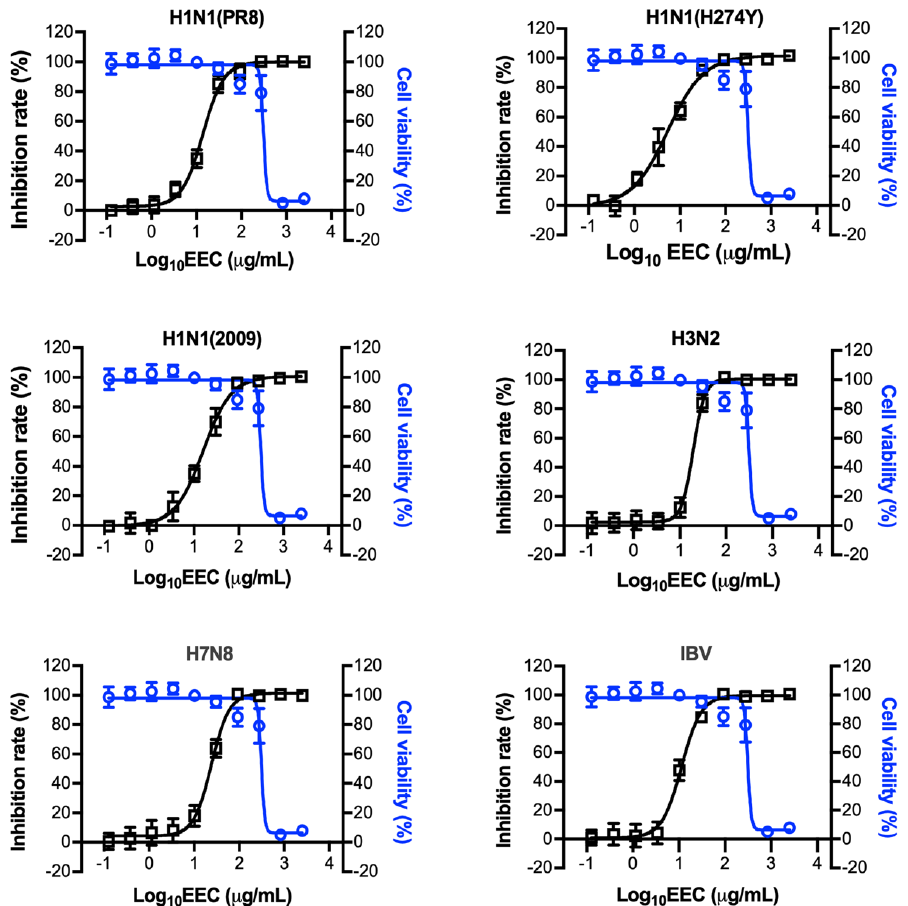
Figure 2. EEC has a broad spectrum of antiviral activities against influenza viruses in A549 cells. A549